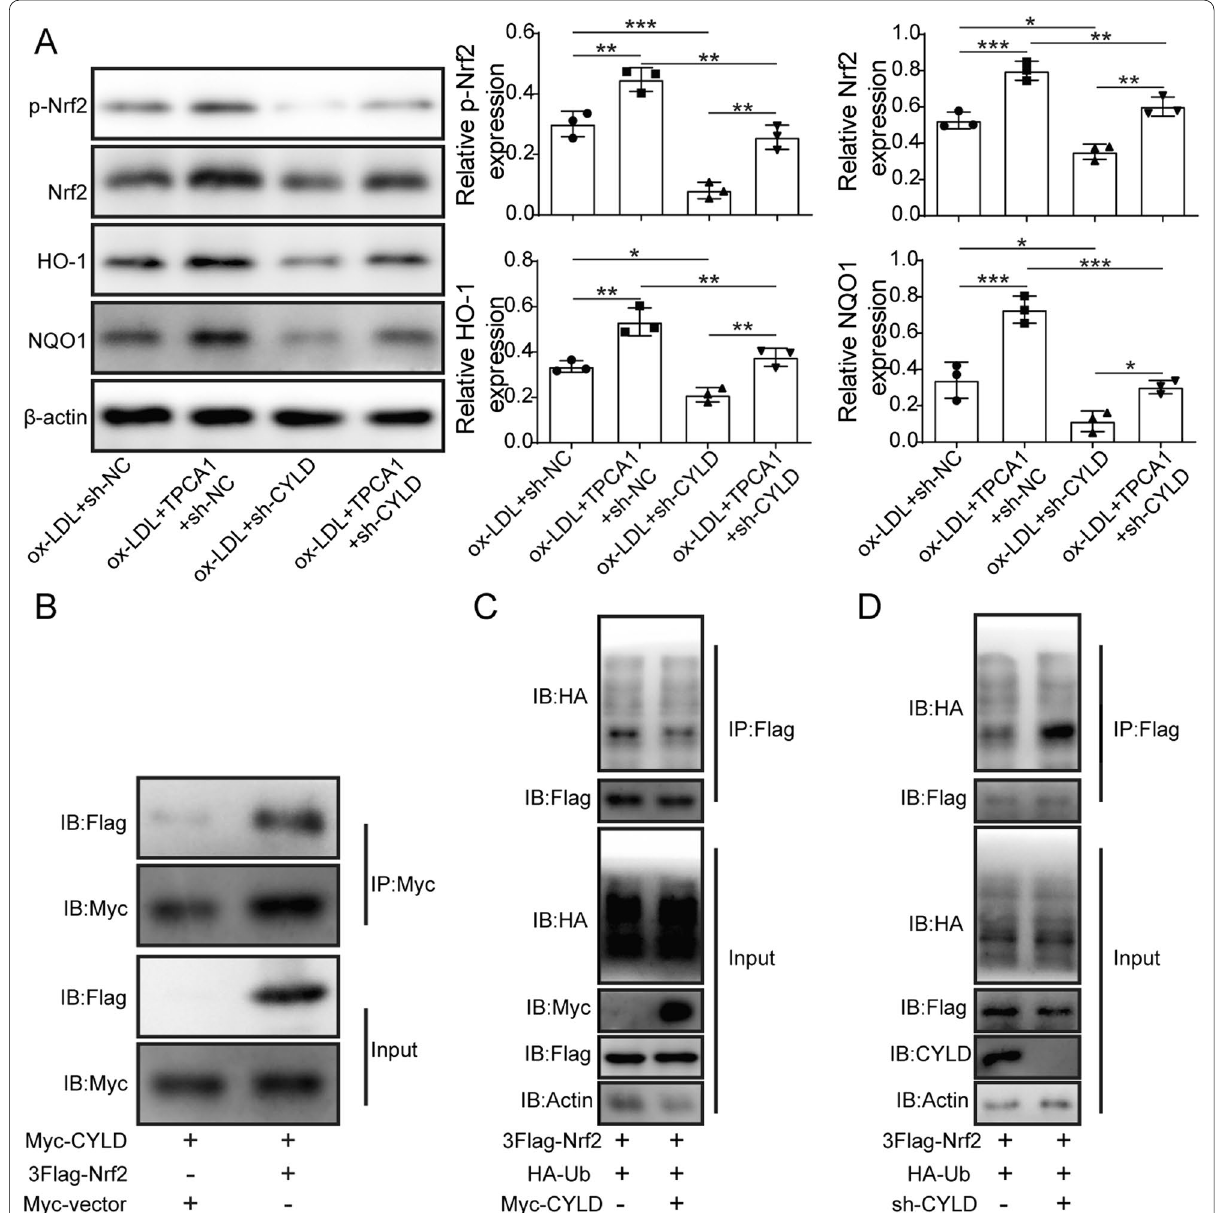
Fig. 6 The deubiquitinase CYLD reduced the ubiquitination of Nrf2. A The protein expression levels of p‑Nrf2, Nrf2, HO‑1 and NQO1 in treated HK‑2 cells. B The interaction between CYLD and Nrf2 was analysed using Co‑IP. C and D Co‑IP was performed to assess the effect of CYLD on the ubiquitination of Nrf2. CYLD, cylindromatosis; Nrf2, NF‑E2‑related factor 2; HO‑1, haem oxygenase 1; NQO1, NAD(P)H dehydrogenase quinone 1; HK‑2, human kidney 2; Co‑IP, co‑immunoprecipitation. Significance was assessed by an ANOVA test. The experimental data are shown as the mean SD. N 3. *P < 0.05, **P < 0.01, ***P < ± =